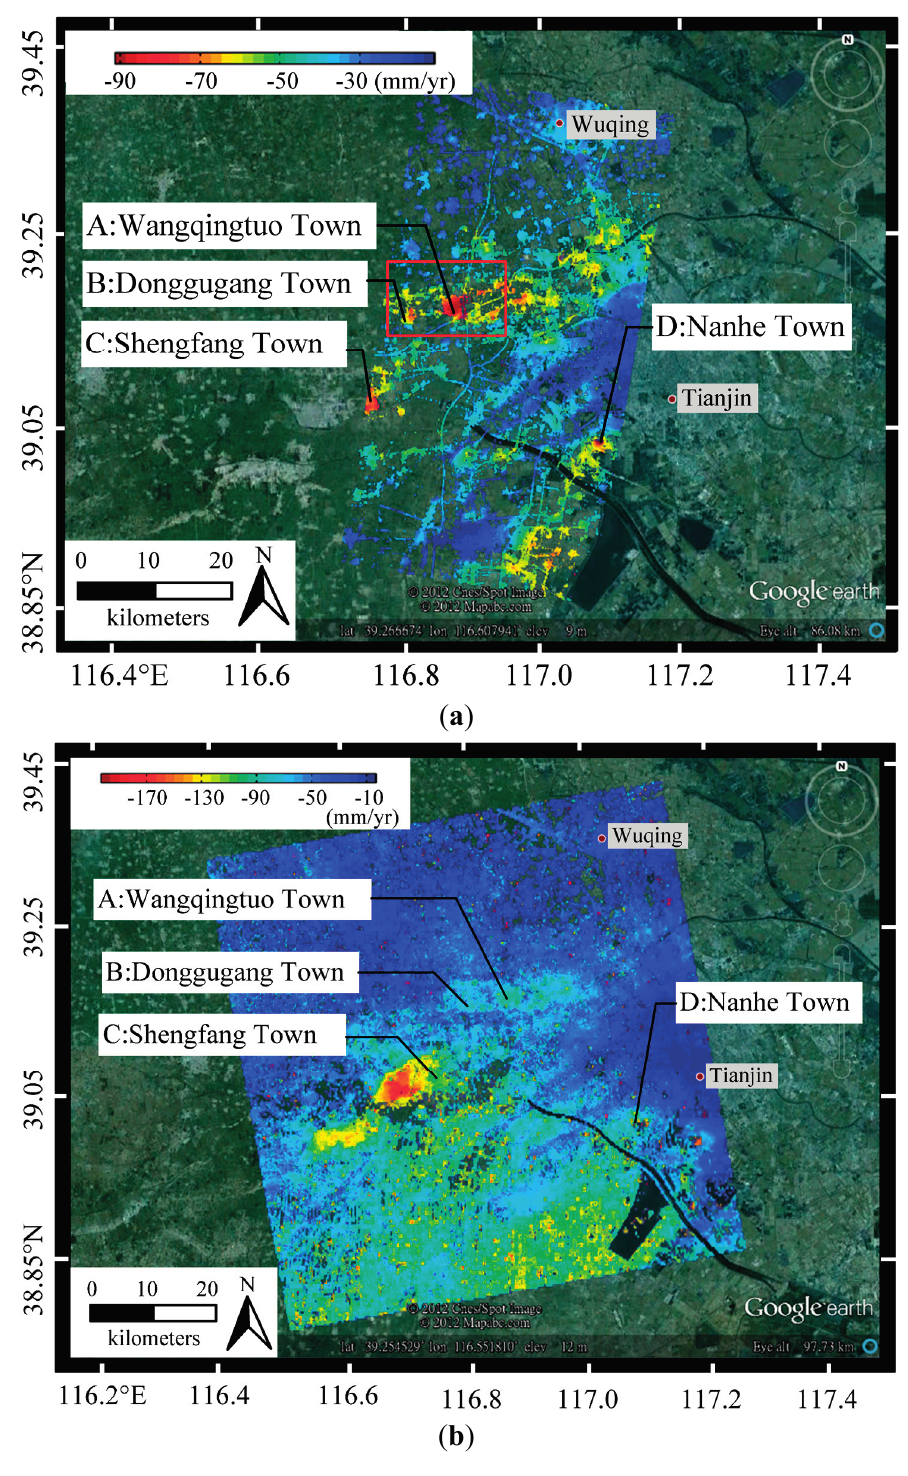
Figure 4. Linear deformation trends along line of sight (LOS) direction. Three major subsiding centers are located in A: Wangqingtuo Town, B: Dongguguang Town, C: Shengfang Town, D: Nanhe Town. ( a ) Linear deformation trend of TSX using PS analysis. The colorbar ranges from − 90 to − 10 mm/year [23]; ( b ) Linear deformation trend of ALOS-PALSAR using the QPS technique. The colorbar ranges from − 190 to − 10